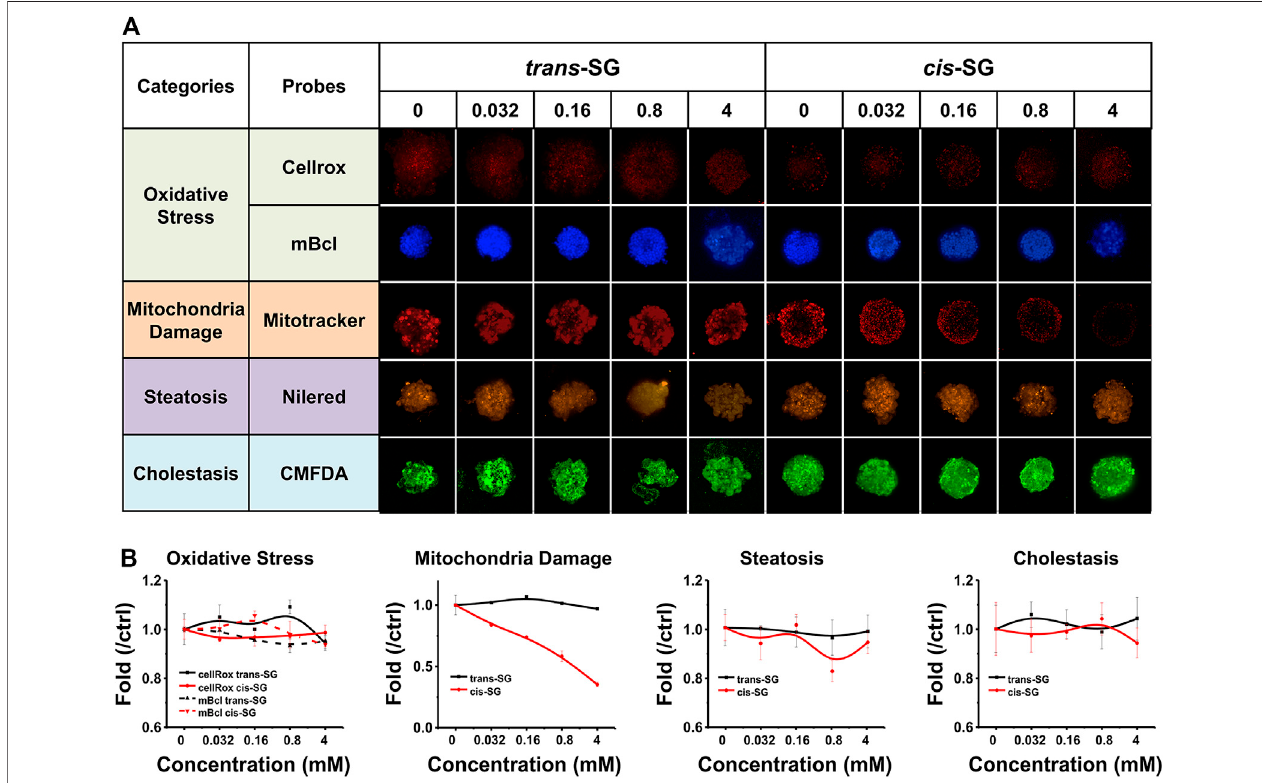
FIGURE 4 | Multiparametric HCA of assessments on 3D cultured HepaRG organoids with trans -SG and cis -SG exposure for 24 h. (A) Representative confocal images shown corresponding to trans-SG and cis-SG . After incubation, 5 fl uorescence-based endpoints were measured to assess chemically induced alterations in cellular function. (B) Image analysis readouts were derived to evaluate four kinds of different cellular alterations, including oxidative stress, mitochondria damage, steatosis, and cholestasis. Values are expressed as mean ±